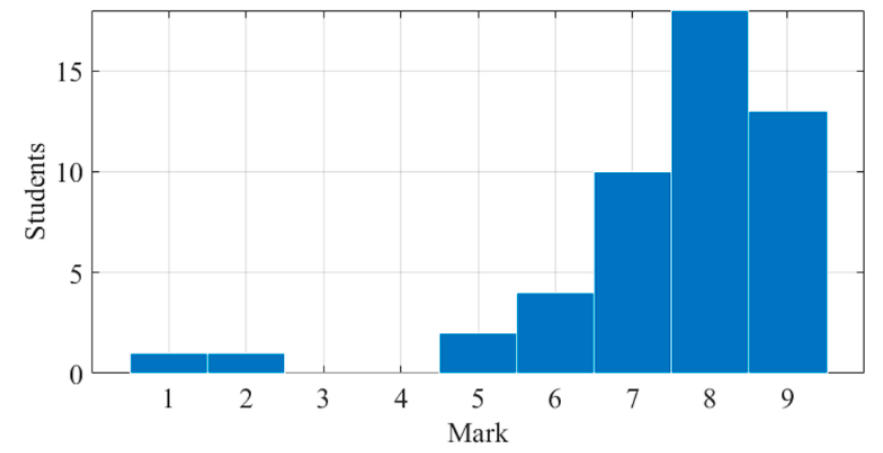
Figure 13. Students’ marks in the proposed exercises about PID